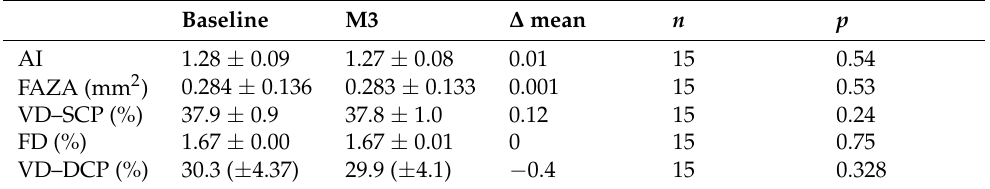
Table 5. Patterns of variation in OCT-A metrics in the control group. Data presented as mean ( ± SD).